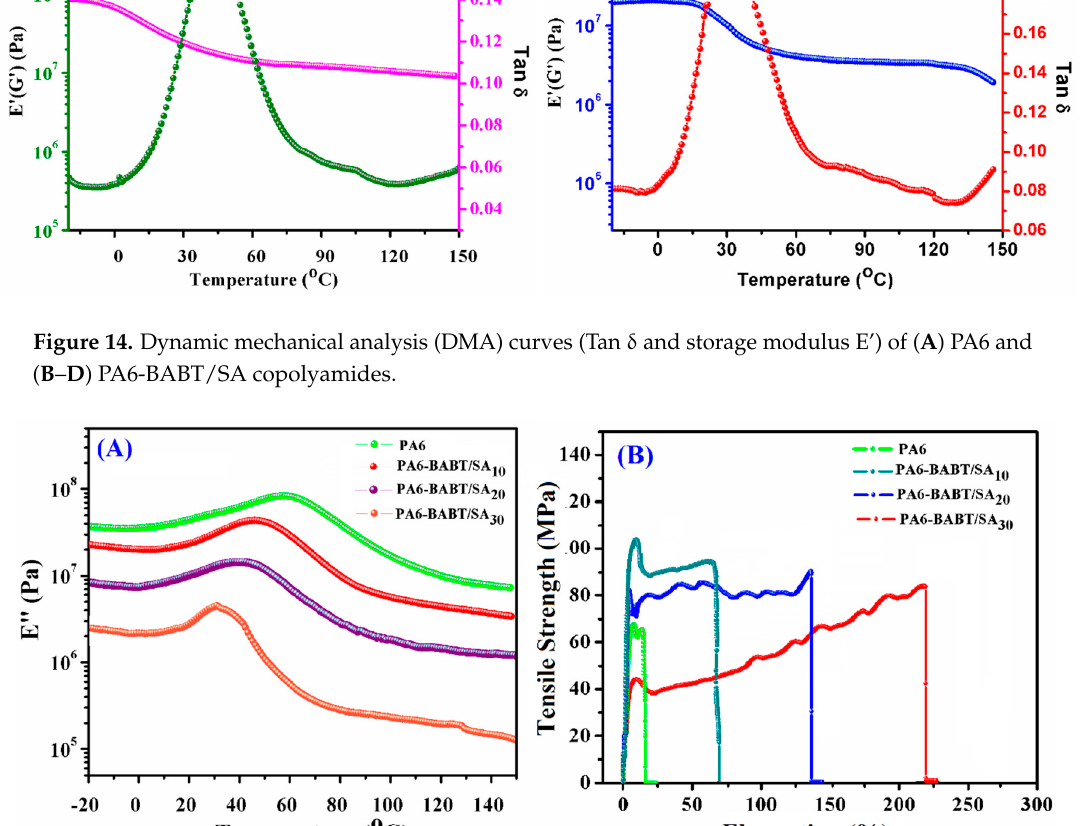
Figure 14. Dynamic mechanical analysis (DMA) curves (Tan δ and storage modulus E’) of ( A ) PA6 and ( B – D ) PA6-BABT/SA copolyamides. Table 5. Mechanical properties of PA6 and PA6-BABT/SA copolyamides.